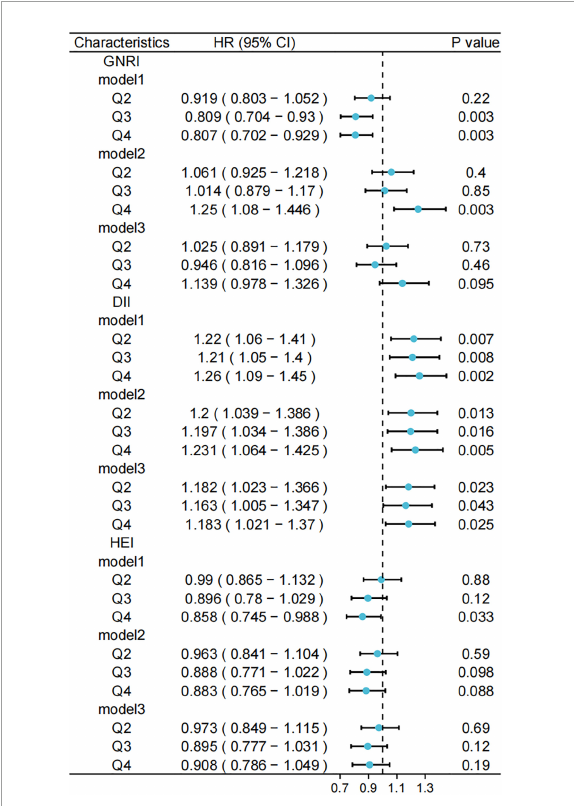
FIGURE6 Relationship between different scores and risk of cardiovascular and cerebrovascular diseases (CCVD) mortality. Standardized scores were divided into four groups (Q1, Q2, Q3, and Q4) according to the 25th, 50th, and 75th quartiles, with the Q1 group used as a reference. Model 1 was unadjusted for variables and Model 2 was adjusted for age, sex, race, marital status, and household income at baseline; Model 3 was further adjusted for history of hypertension, hyperlipidemia, and diabetes. GNRI, geriatric nutritional risk index; DII, dietary inflammatory index; HEI, healthy eating